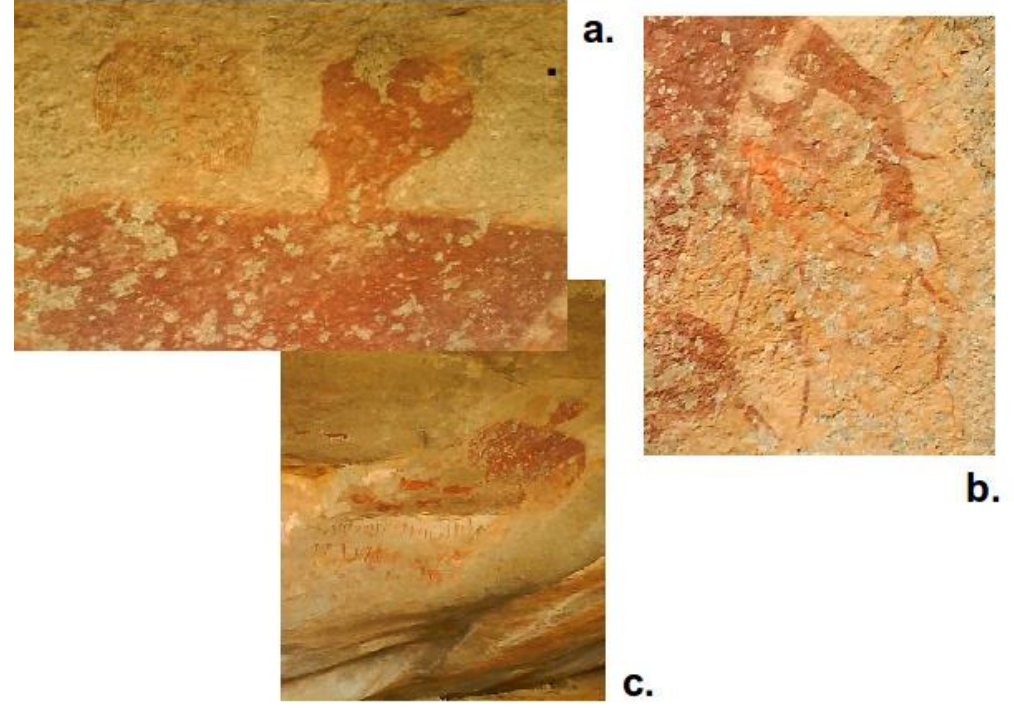
Figure 3. ( a ) Double-headed human-like figure from the upper Amis gorge, Brandberg/Dâures, Namibia; ( b ) Close up of human figures “pouring” from the left armpit of the figure; ( c ) The figure in context of part of the broader panel, so as to give some idea of scale. Photos: Sian Sullivan, 2007, personal